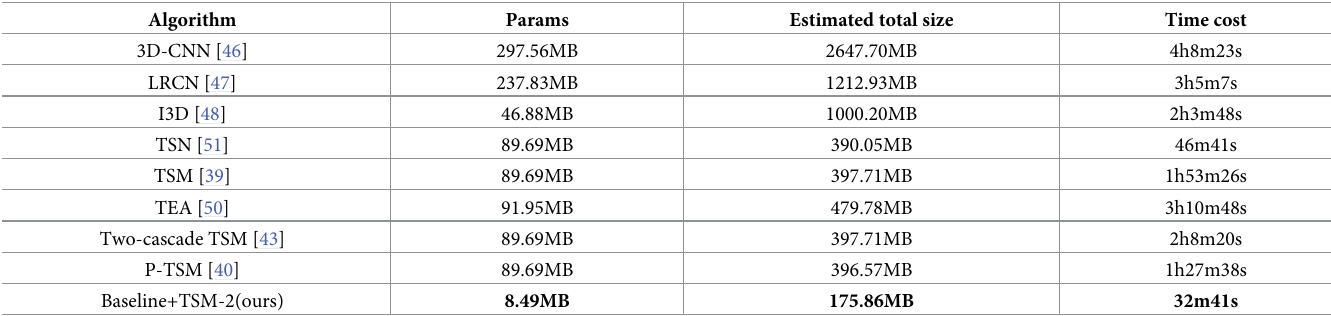
Table 5. Complexity of different